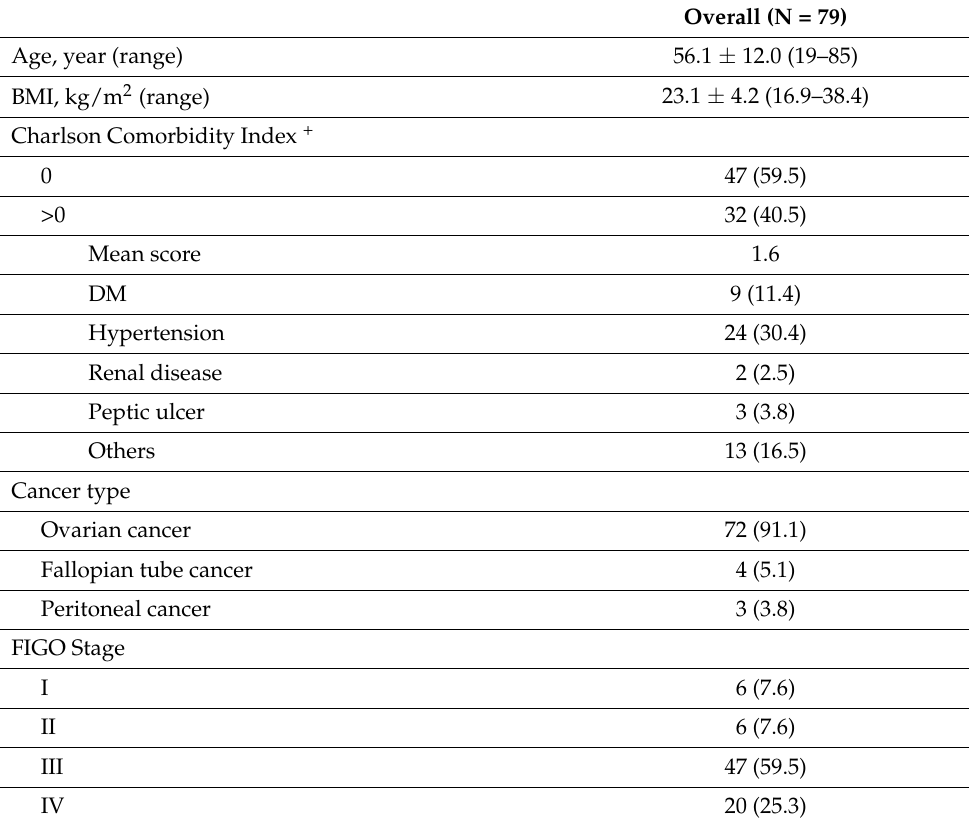
Table 1. Clinico-pathologic features of enrolled